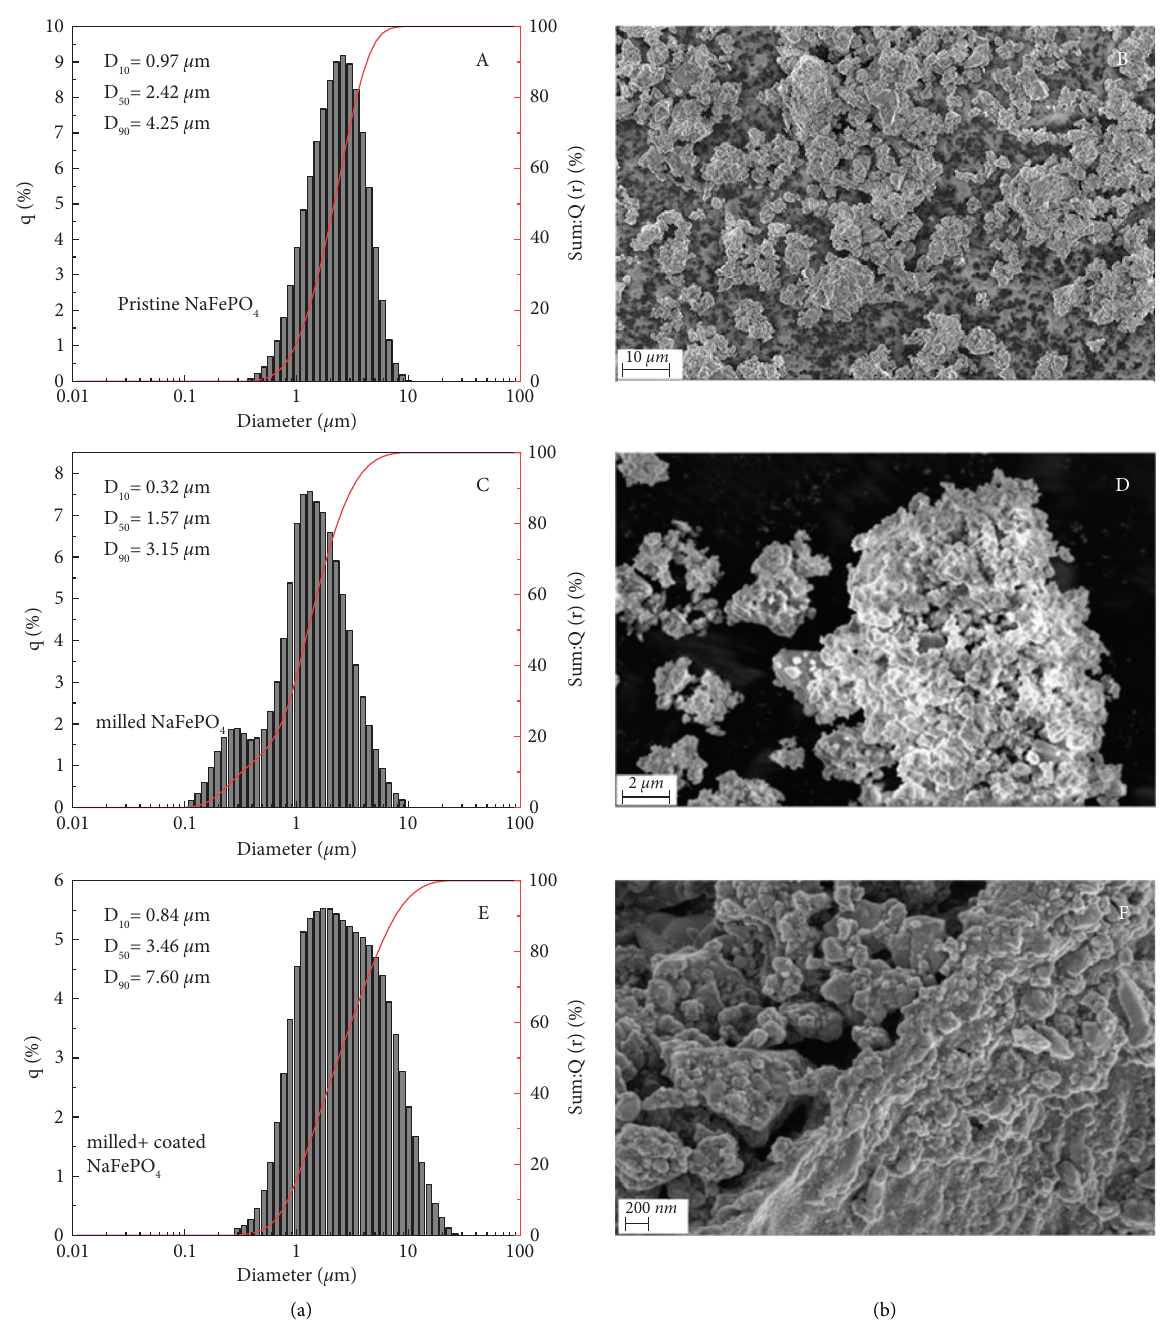
Figure 6: Particle size distribution (a) and SEM images (b) of NaFePO glucose coated